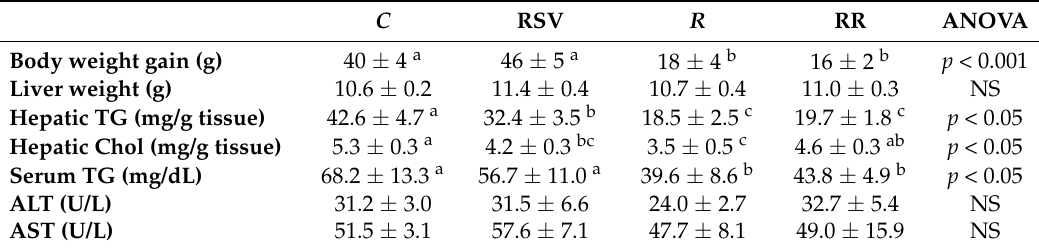
Table 1. Body weight gain, liver weight, hepatic triacylglycerol (TG) content, liver cholesterol (Chol) content and serum triacylglycerol, alanine aminotransferase (ALT) and aspartate aminotransferase (AST) concentrations of rats fed on the experimental diets for six weeks, and then fed a standard diet (C), or a standard diet supplemented with resveratrol (RSV), or submitted to energy restriction and fed a standard diet (R) or submitted to energy restriction and fed a standard diet supplemented with resveratrol (RR) ( n = 9/group) for additional six weeks.